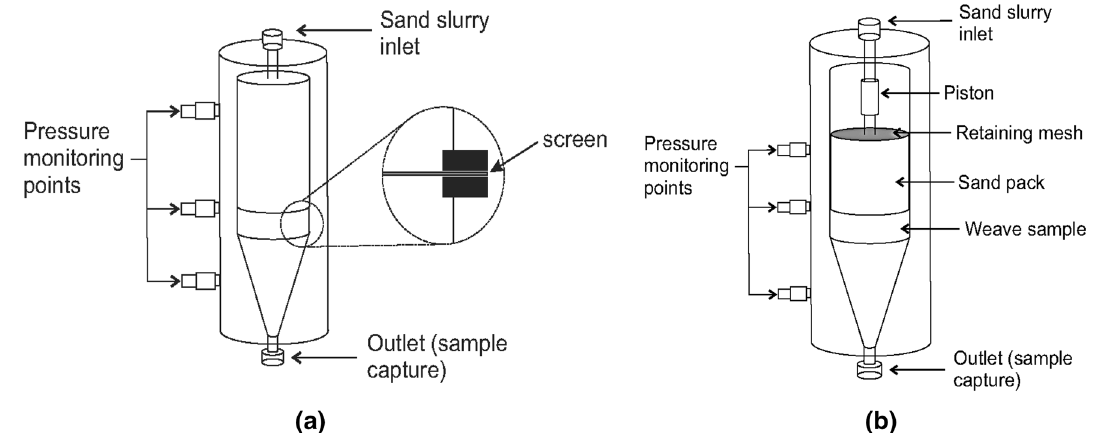
Fig. 4 Schematic diagrams of a slurry test setup, b sand-pack test setup. Modified after Agunloye and Utunedi